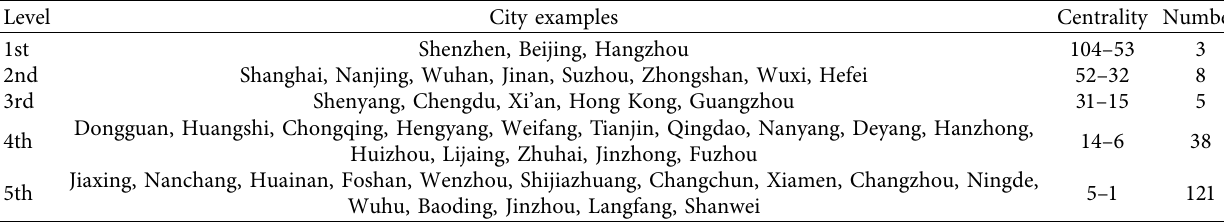
Table 3: Centrality hierarchy of the cities of the comprehensive